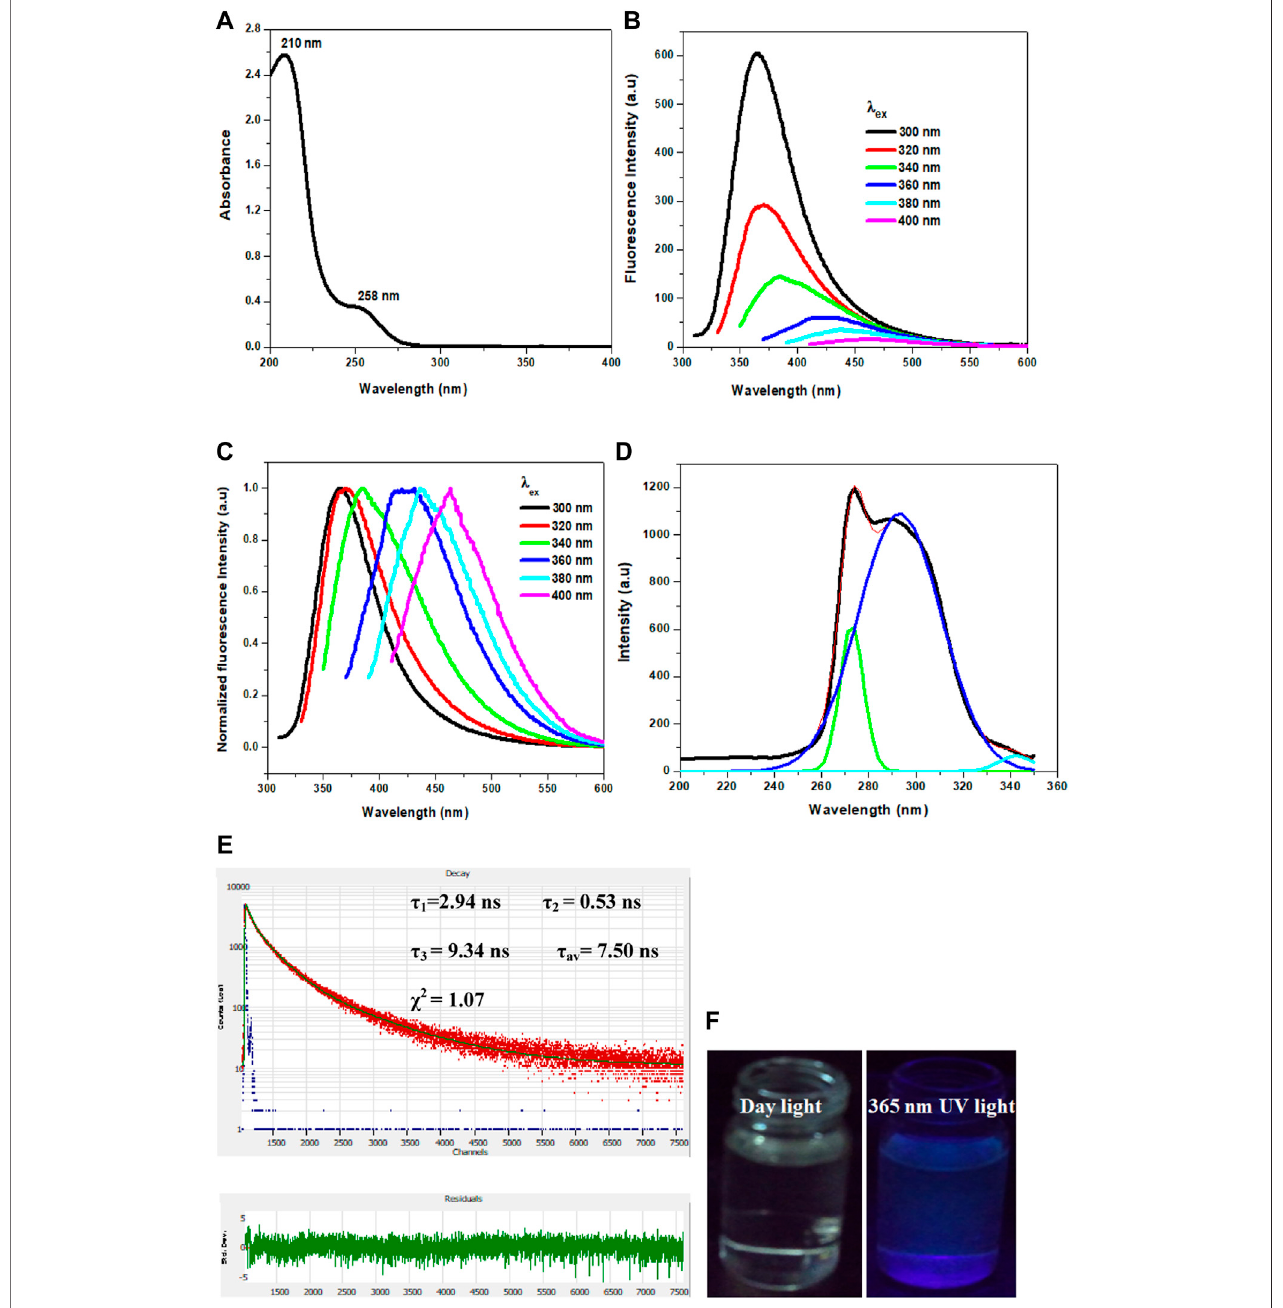
FIGURE 3 | (A) UV-visible spectrum of Cl-CNDs in aqueous medium. (B) Fluorescence spectra of Cl-CNDs with variation of excitation wavelength from 300 to 400 nm in aqueous medium (C) corresponding normalized plot of (B) . (D) Fluorescence excitation spectra of Cl-CNDs monitored at 360 nm emission in aqueous medium with deconvolution showing the multiple peaks. (E) Time resolved fl uorescence decay curve of Cl-CNDs with residual fi tting. (F) Photograph of fl uorescence of Cl-CNDs in aqueous dispersion under daylight and 365 nm UV light irradiation respectively.